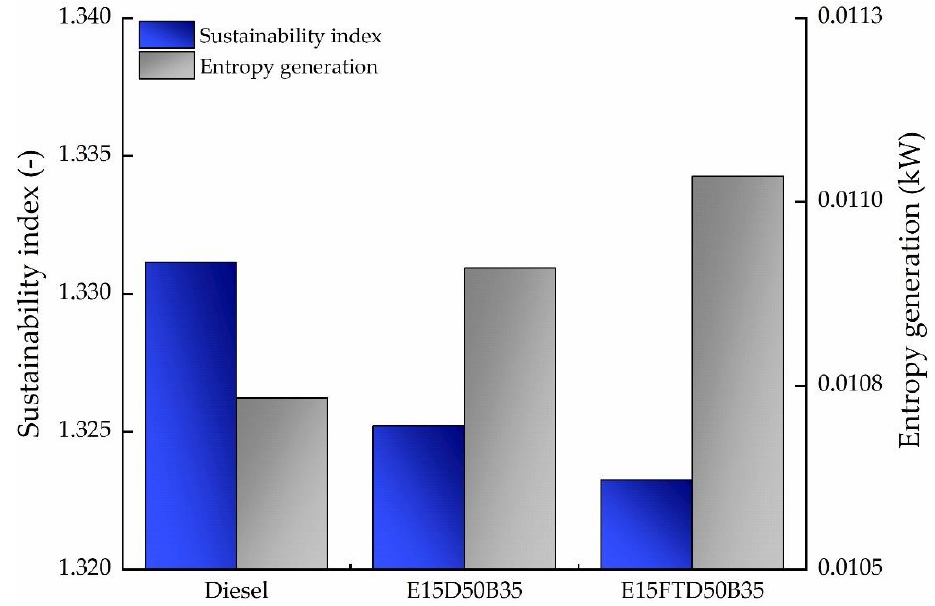
. S gen ) values of the tested